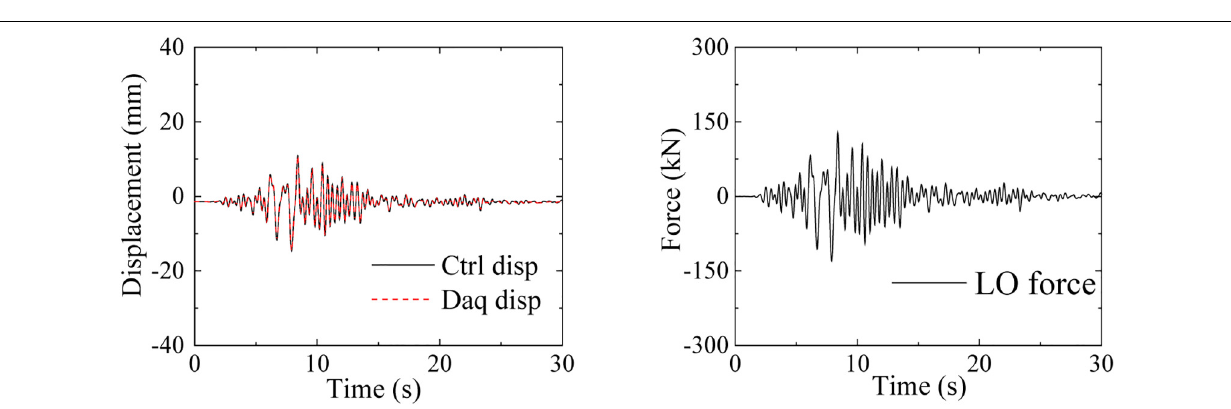
FIGURE 9 | Time histories of the shear force and deformation (NO case).